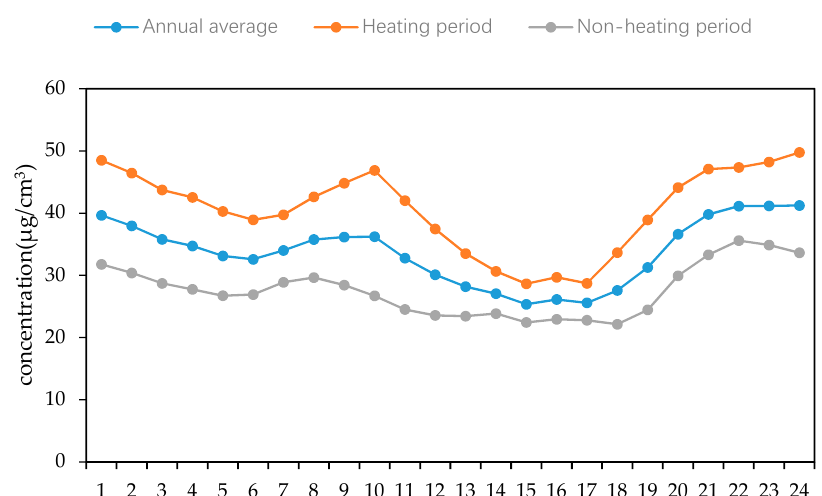
Figure 6. Variation in the PM 2.5 concentration in the heating period and non-heating period in Changchun City in 2018.